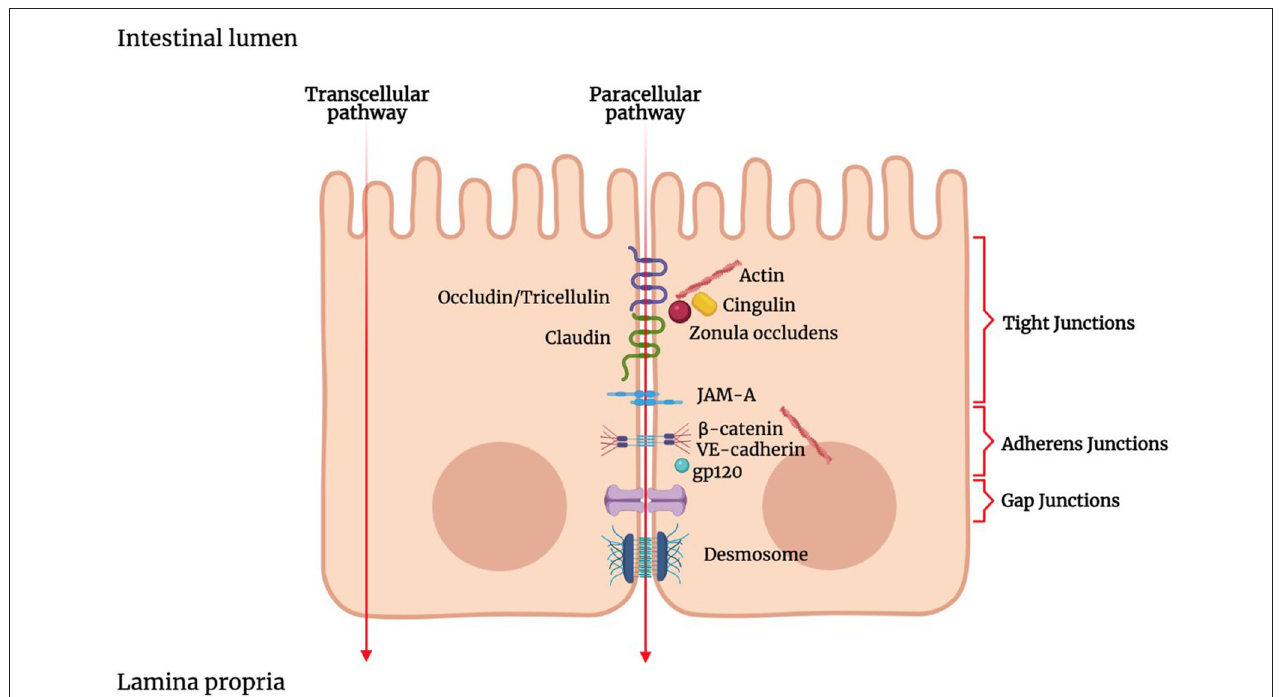
FIGURE 1 | Schematic representation of the junctional complex in intestinal epithelium. Molecules can cross the intestinal epithelial monolayer through the intercellular space (paracellular route) or through the cells (transcellular route). The junctional complex involved in paracellular pathway includes tight junctions, adherens junctions, gap junctions and desmosomes. Tight junctions are composed of transmembrane proteins such as claudins, occludin, junctional adhesion molecule (JAM), and zonula occludens proteins (ZOs). ZOs, act as scaffold proteins, connecting claudins and occludin to cytoskeletal actin.